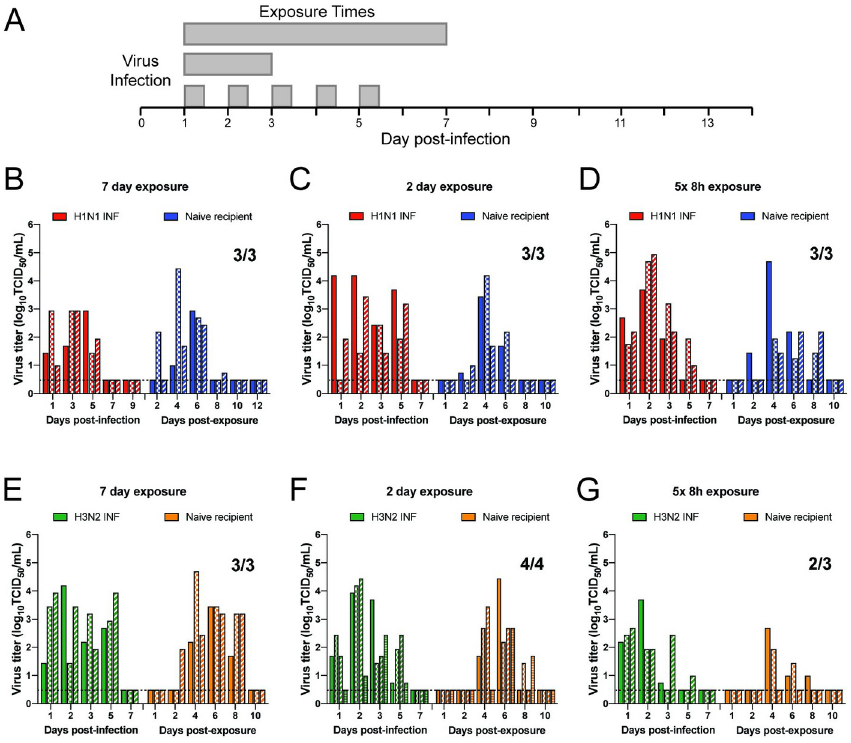
Fig 1. Efficient transmission of seasonal H1N1 and H3N2 influenza viruses to na ï ve animals under short or periodic exposures. (A) Schematic of experimental procedure. Shaded gray bars depict exposure times. Three to four donor ferrets were infected with A/CA/07/2009 (H1N1) (B-D) or A/Perth/16/2009 (H3N2) (E-G) and a na ï ve recipient ferret was placed in the adjacent cage at 24 hour post-infection for 7 (B and E) or 2 (C and F) continuous days, or 8 hours a day for 5 consecutive days (D and G). Nasal washes were collected from all ferrets on the indicated days and each bar indicates an individual ferret. Limit of detection is indicated by dashed line. Viral titers for donor animals in part G have previously been published in